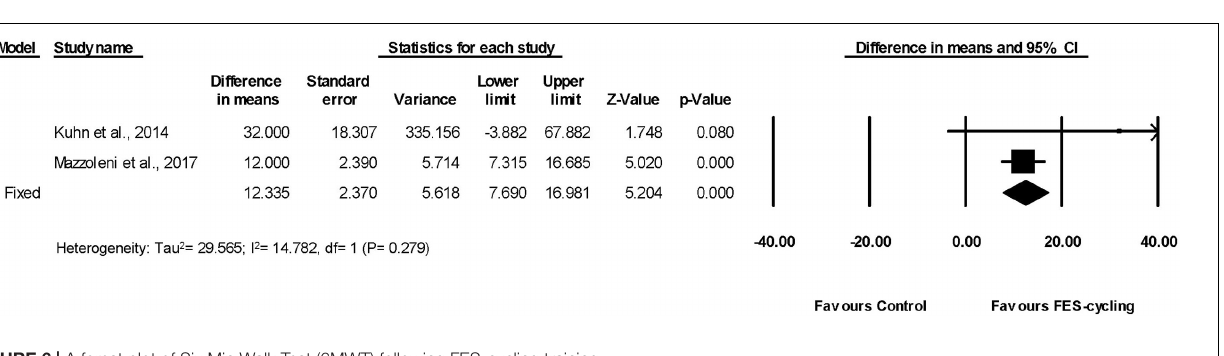
FIGURE 6 | A forest plot of Six Min Walk Test (6MWT) following FES-cycling